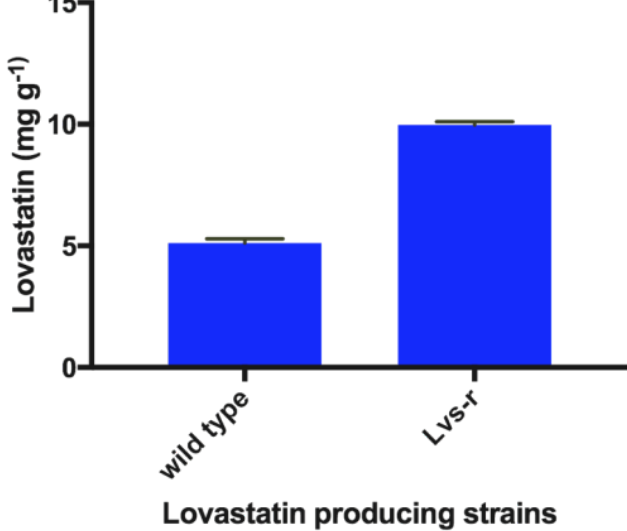
Figure 4. Lovastatin production in the wild-type and lovastatin-resistant strains (Lvs-r).